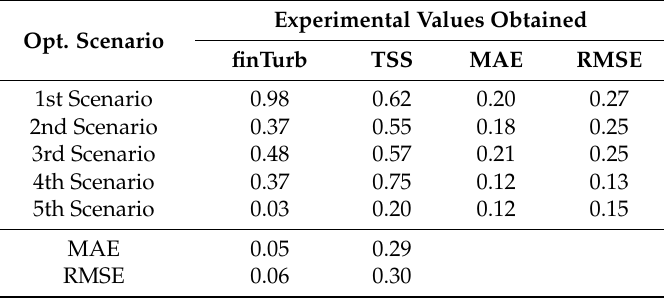
Table 21. Experimental outputs that were obtained according to the five clarification optimization scenarios for ECOTAN